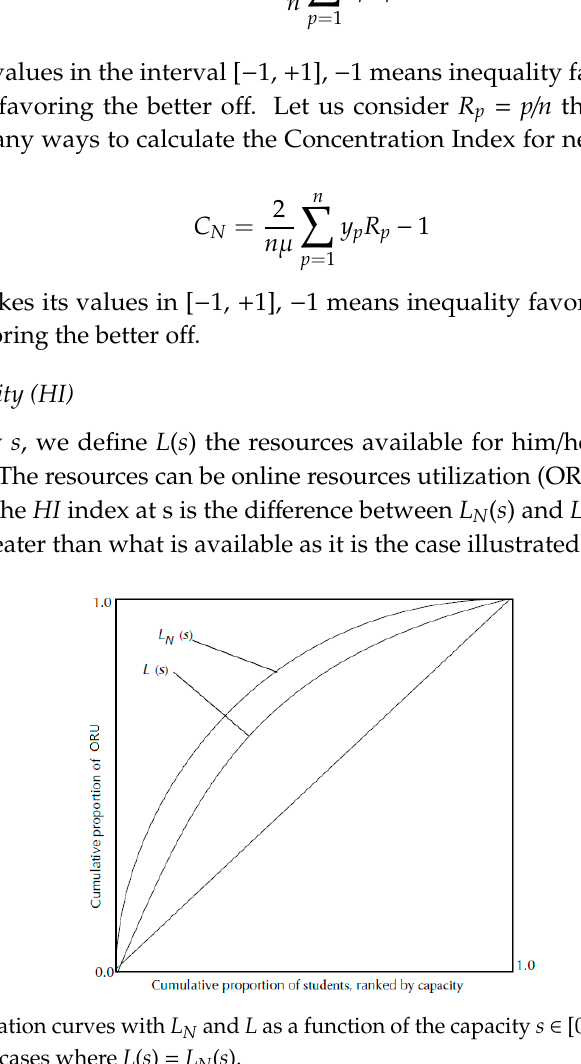
(4) The second term on the right is the generalized concentration index for 𝜀 (cid:3043) . It compensates the